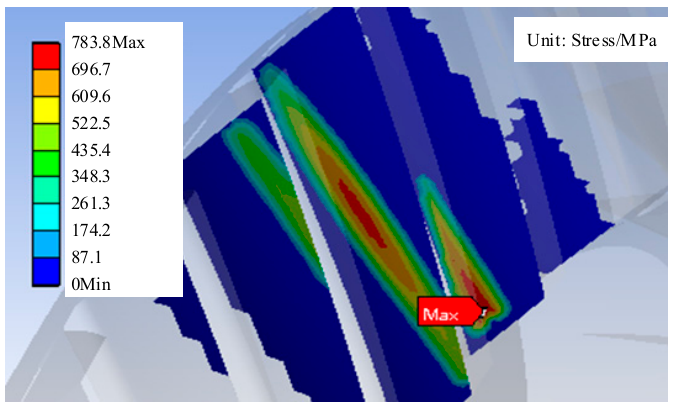
Figure 18. Contact stress of the surface of driven bevel gear at 4th ND rotation speed.